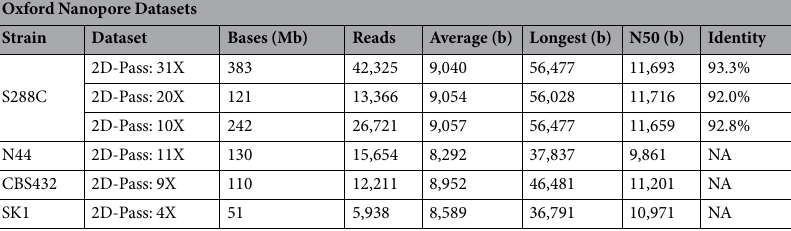
Table 1. Statistic information for the 2D-Pass ONT datasets for the S288C, N44, CBS432 and SK1 strains. For the S288C strain, also shown are a 20X and a 10X subsets of randomly selected reads from the immediately larger 2D-Pass dataset.